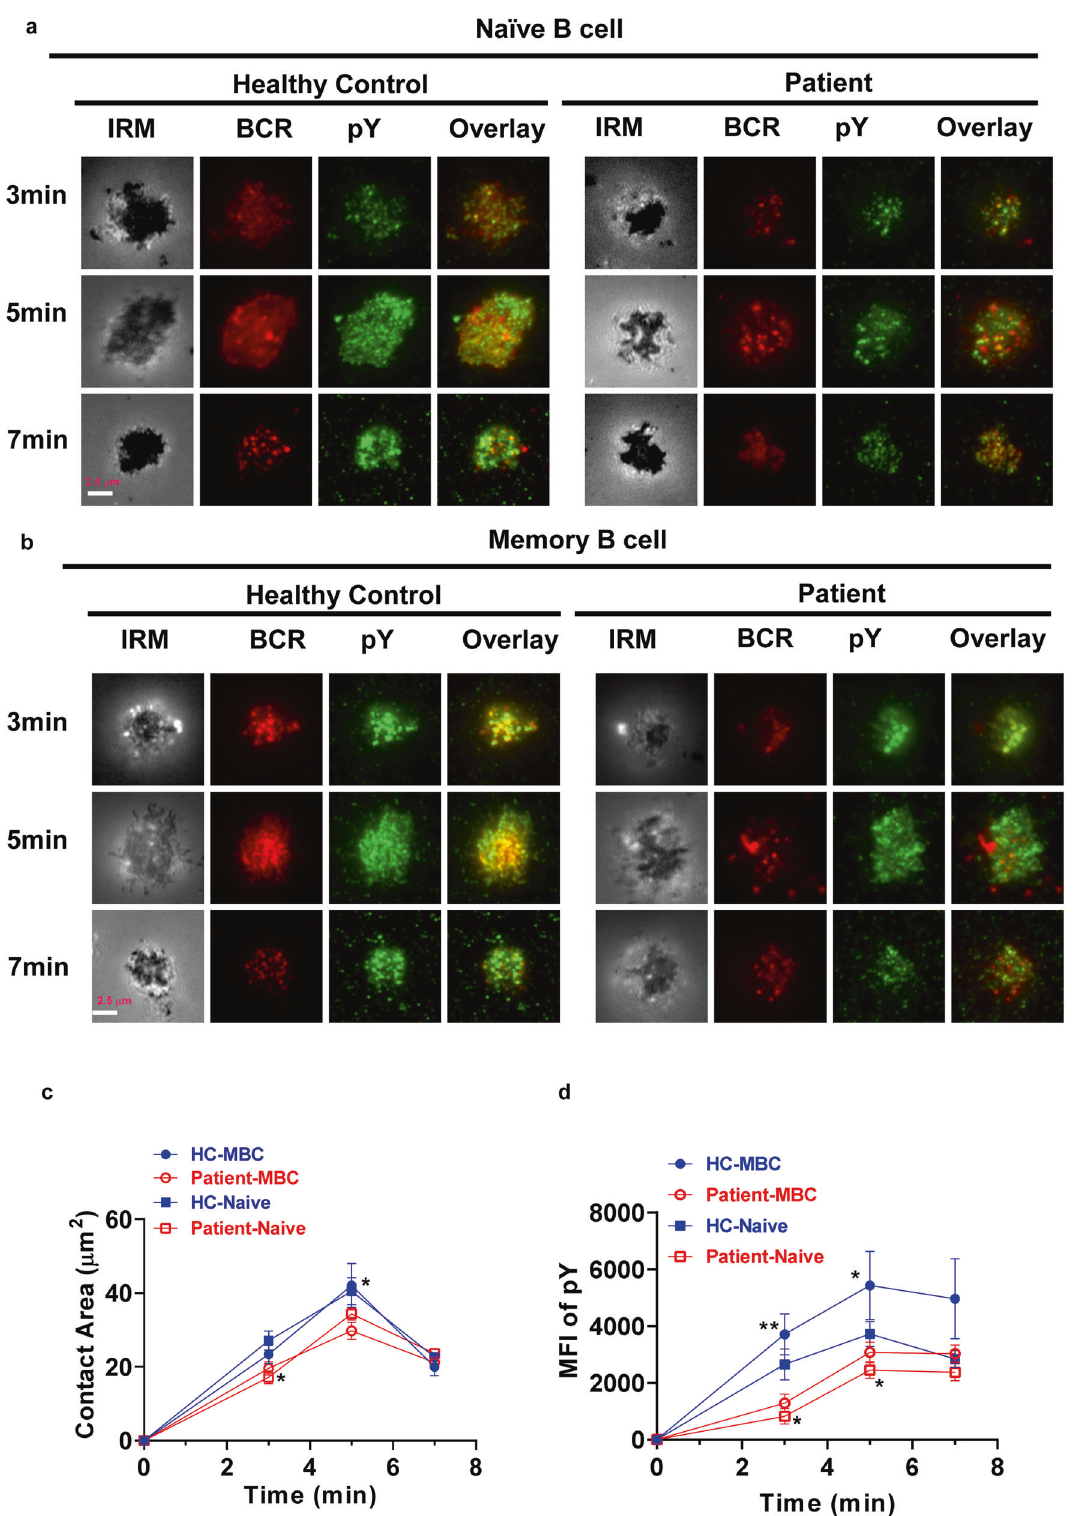
Fig. 4 SARS-CoV-2 infection alters the BCR signaling through affecting the B-cell early activation. Naive (CD27 − ) and memory (CD27 + ) B cells from COVID-19 recovered patients and healthy controls were activated with 10 µg/ml AF546 – mB-Fab ′ – anti-Ig tethered to lipid bilayers at 37 °C for 3, 5 and 7 min. Then cells were fi xed, permeabilized, and stained with Alexa Fluor 647 anti-CD27 and anti-pY ( a , b ), followed by Alexa Fluor 488 goat anti-mouse IgG. Cells were analyzed by Tirf microscope. Shown are representative images, the mean values of the B-cell contact area ( c ), and the MFI of pY ( d ) in the contact zone from three independent experiments. Scale bars, 2.5 μ m. Statistical evaluation was performed using the two-tailed Student ’ s t -test. Statistical signi fi cance is indicated using asterisks: * p < 0.05,** p < 0.01, *** p < 0.001, and **** p <